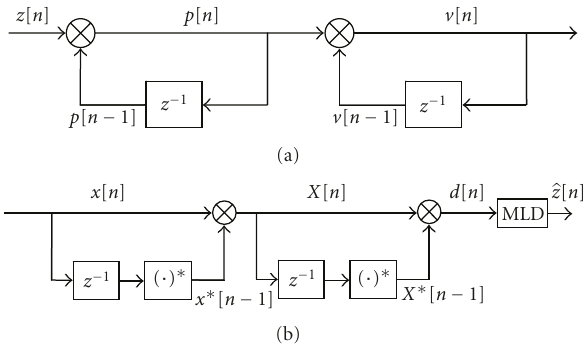
Figure 2: Double-di ff erential (a) encoder and (b) decoder.